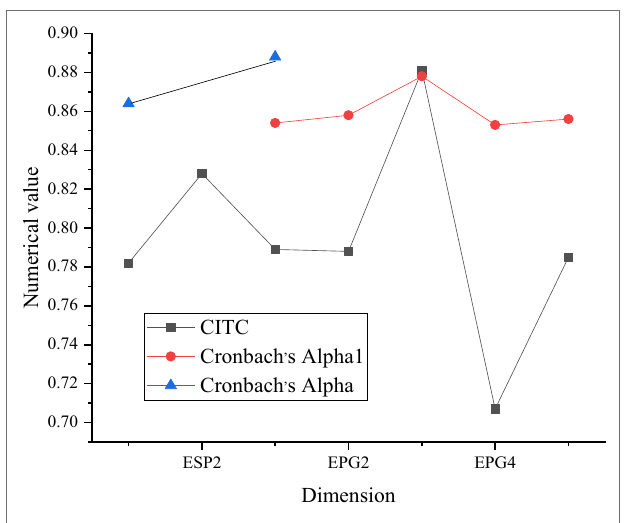
FIGURE 6 | Reliability analysis results of entrepreneurial environment perception scale (EEC3 indicates three evaluation factors of entrepreneurial culture in entrepreneurial environment, EEI3 indicates three evaluation factors of entrepreneurial incentive, EES2 indicates two evaluation factors of entrepreneurial support, EEM3 indicates three evaluation factors of market network, and EEN2 indicates two evaluation factors of non-market